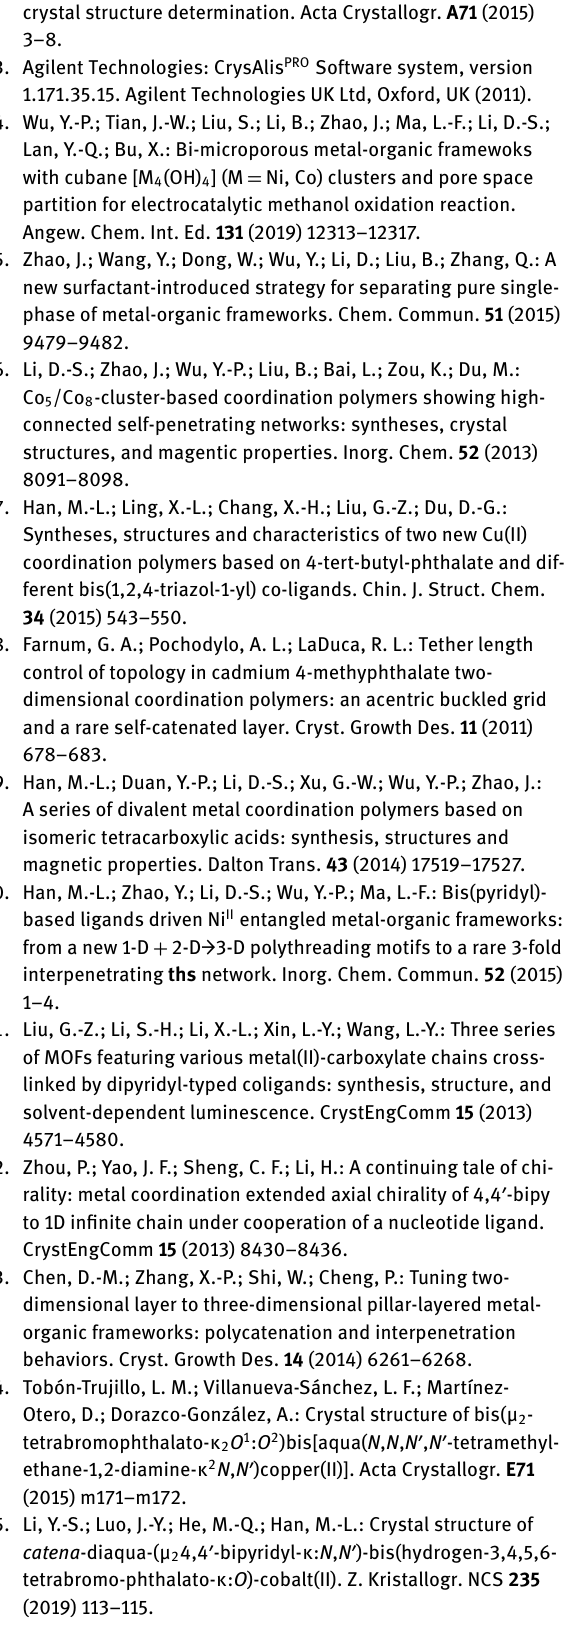
Table 2: Fractional atomic coordinates and isotropic or equivalent isotropic displacement parameters (Å 2